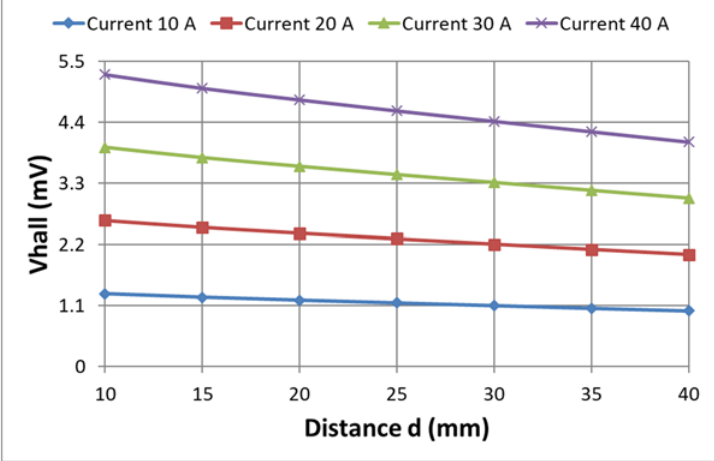
Figure 15. Dependence of the Hall plate voltage Vhall on the distance to the conductor for four different currents.